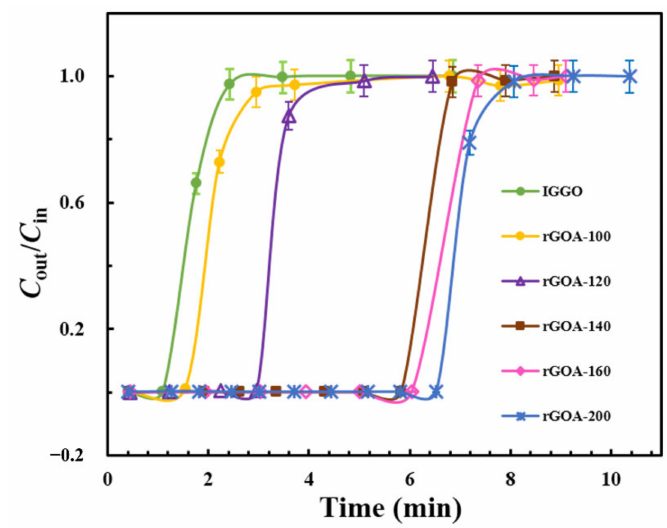
Figure 8. Breakthrough curves of the adsorbents for L2.